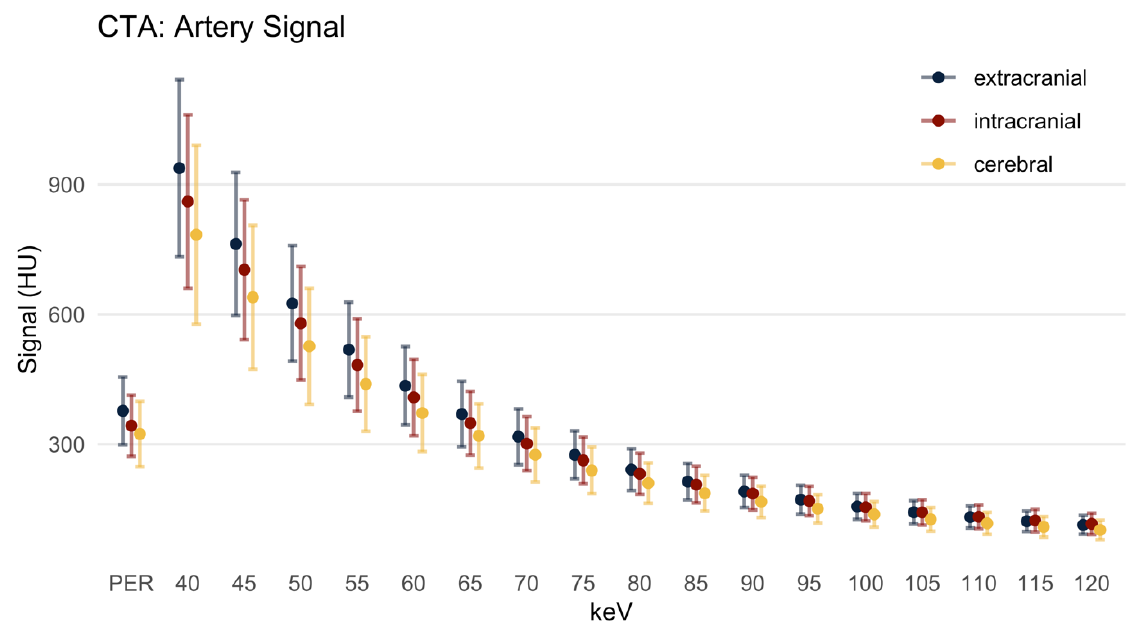
Figure 2. Artery signal in Hounsfield units, mean ± SD. There was a monotonic decrease of the signal with increasing keV level, and the signal of the PER resembled 60–65 keV. HU: Hounsfield units; PER: polyenergetic reconstruction; keV: keV level of the monoenergetic reconstruction. Extracranial: internal carotid artery C1 segment and vertebral artery V3 segment; intracranial: internal carotid artery C4 segment and basilar artery; cerebral: ACA, MCA and PCA.